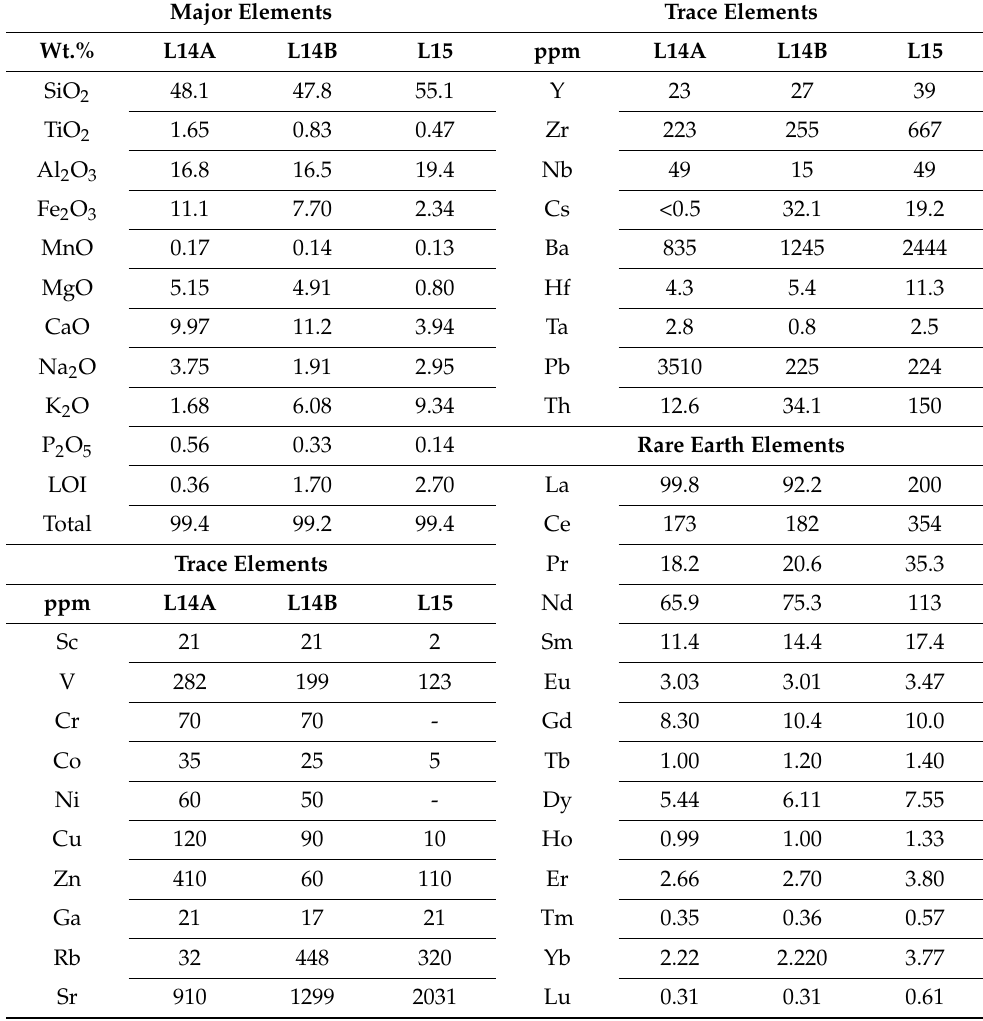
Table 1. Major elements, trace elements, rare earth elements of samples L14A, L14B, L15. Major Elements Trace